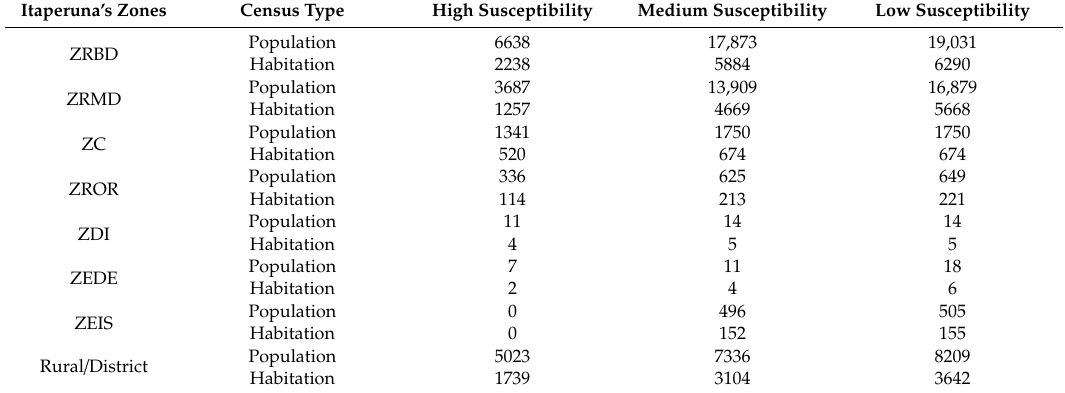
Table 6. The total number of estimated population and habitations (according to the census of 2010) to be a ff ected by floods with three di ff erent degrees of susceptibility: high, medium, and